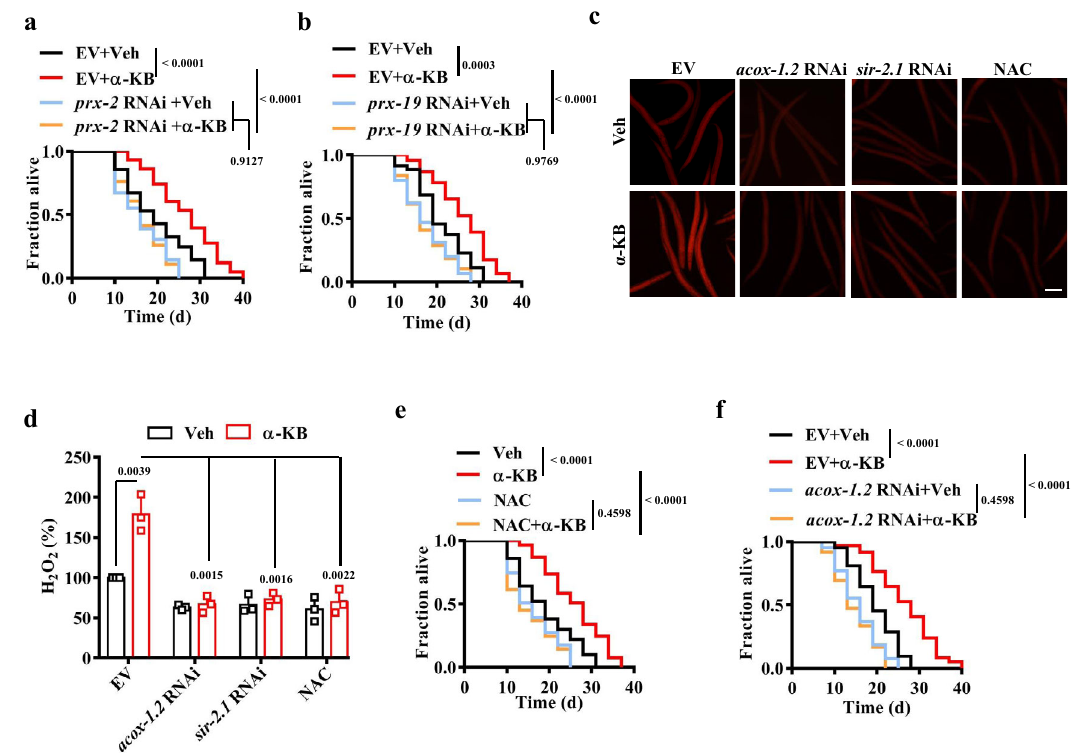
Fig. 4 | Peroxisome function and H 2 O 2 production are involved in α -KB- mediated lifespan extension. a , b RNAi knockdown of prx-2 ( a ) and prx-19 ( b ) inhibited the lifespan extension of wild-type (WT) worms by treatment of α - ketobutyrate ( α -KB, 500 μ M). Veh vehicle. P values ( a , b ) were calculated using a log-ranktest. c Representative images of H 2 O 2 formation detected by fl uorescence dyeDCHP.Scalebars:150 μ m. d Quanti fi cationof fl uorescenceintensity.Thelevels of H 2 O 2 wereincreased inWTwormstreated with α -KB.RNAiknockdownof either acox-1.2 or sir-2.1 inhibitedthelevelsofH 2 O 2 in α -KB-treatedWTworms.Datawere